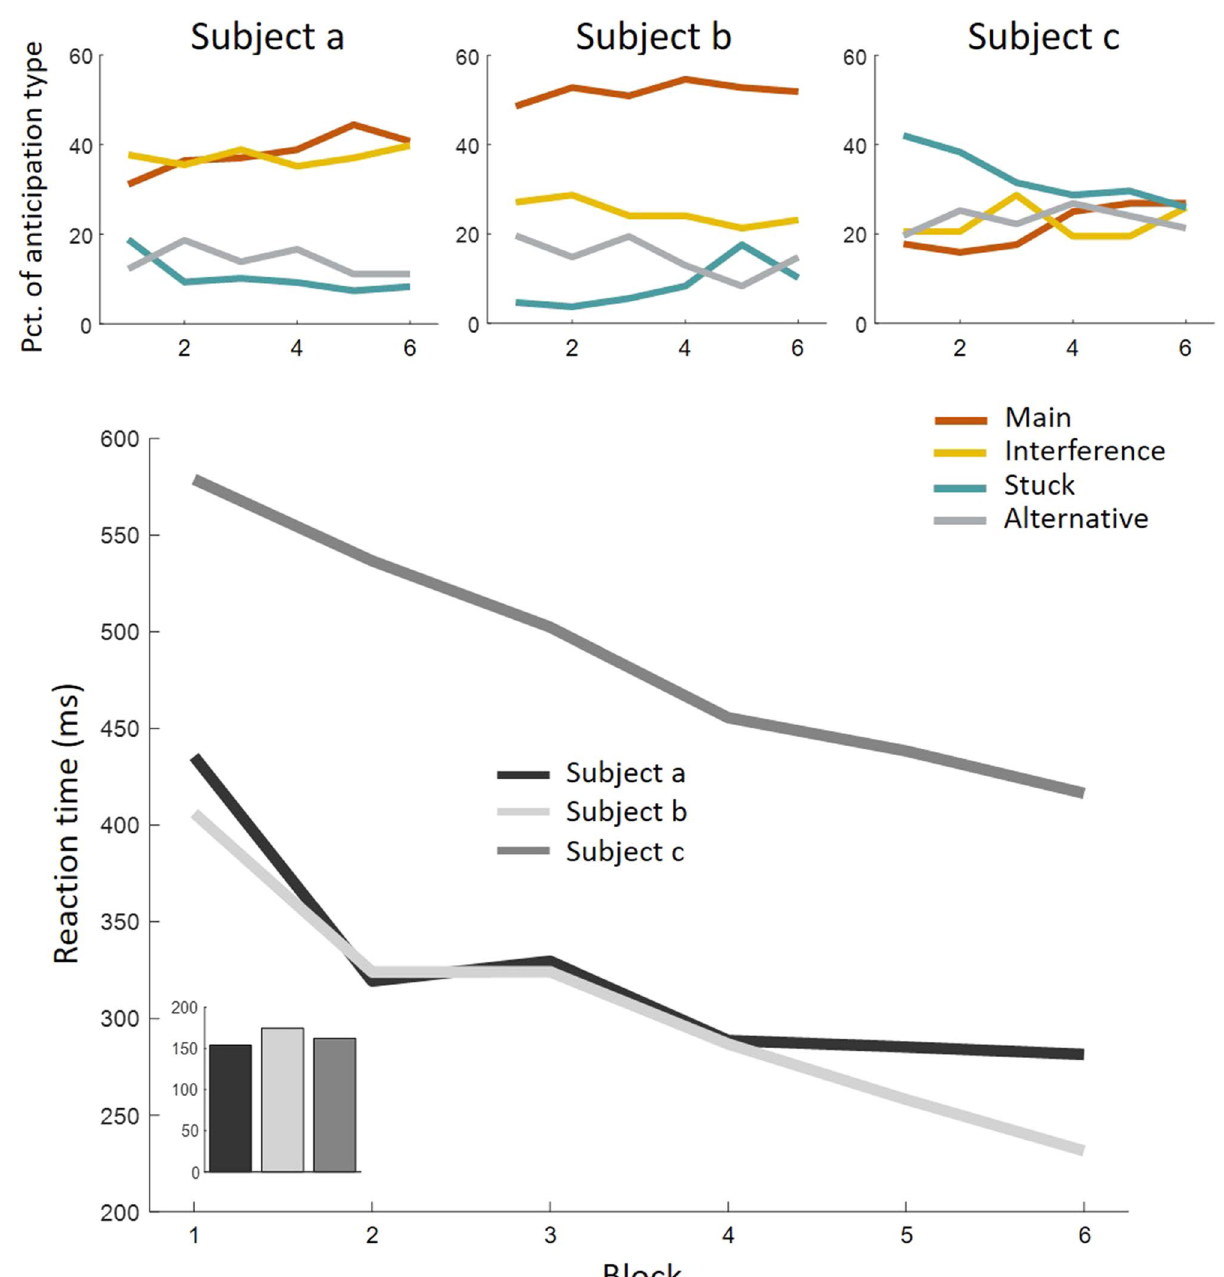
Figure 3. Different underlying processes producing similar learning effects in RT. Top panel: Oculomotor behavior of three participants of the FS group during blocks 1–6. A standard learning effect can be seen